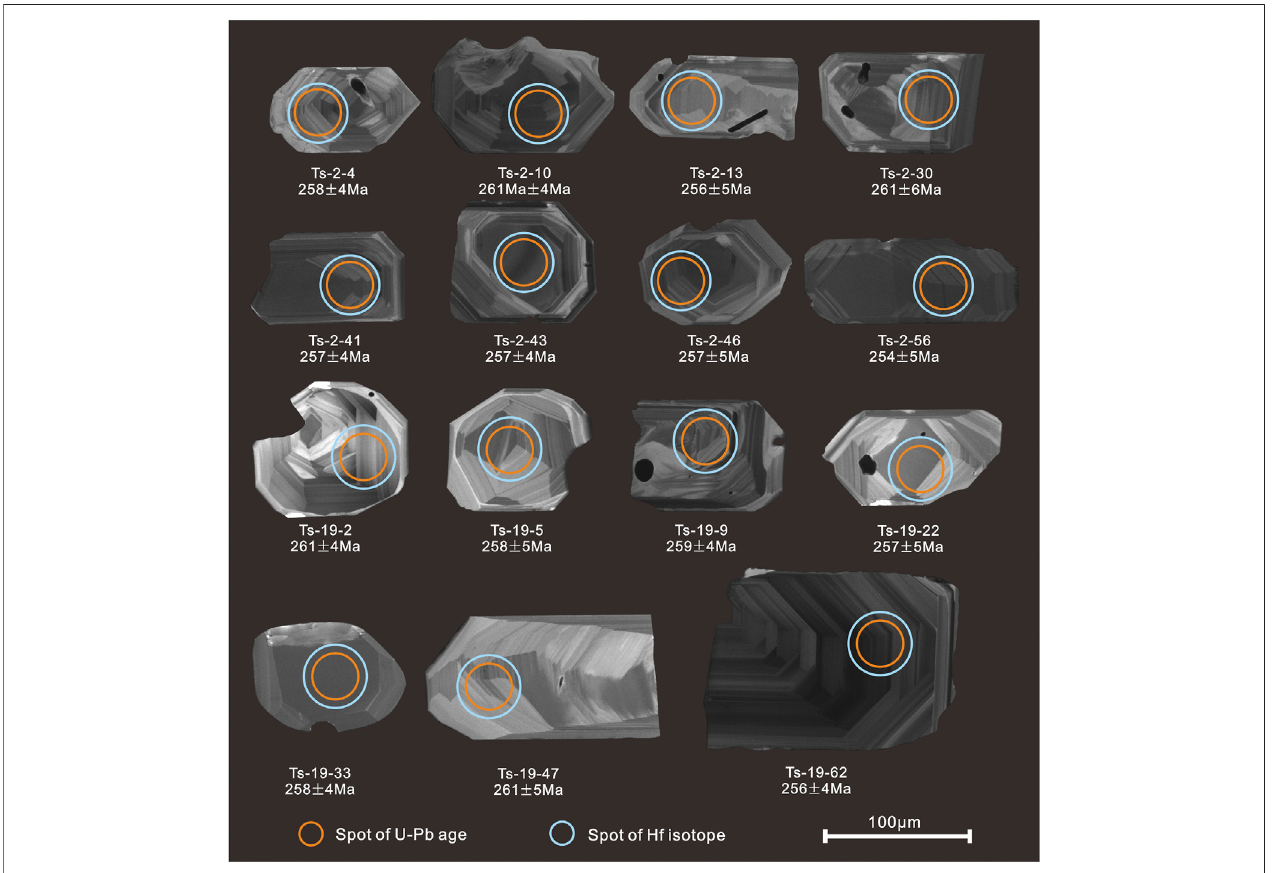
FIGURE 6 | Cathodoluminescence (CL) images of representative zircons from clastic rock samples at Dengchuan.